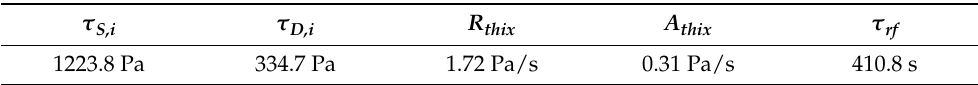
Table 3. 3DCP rheological parameters.